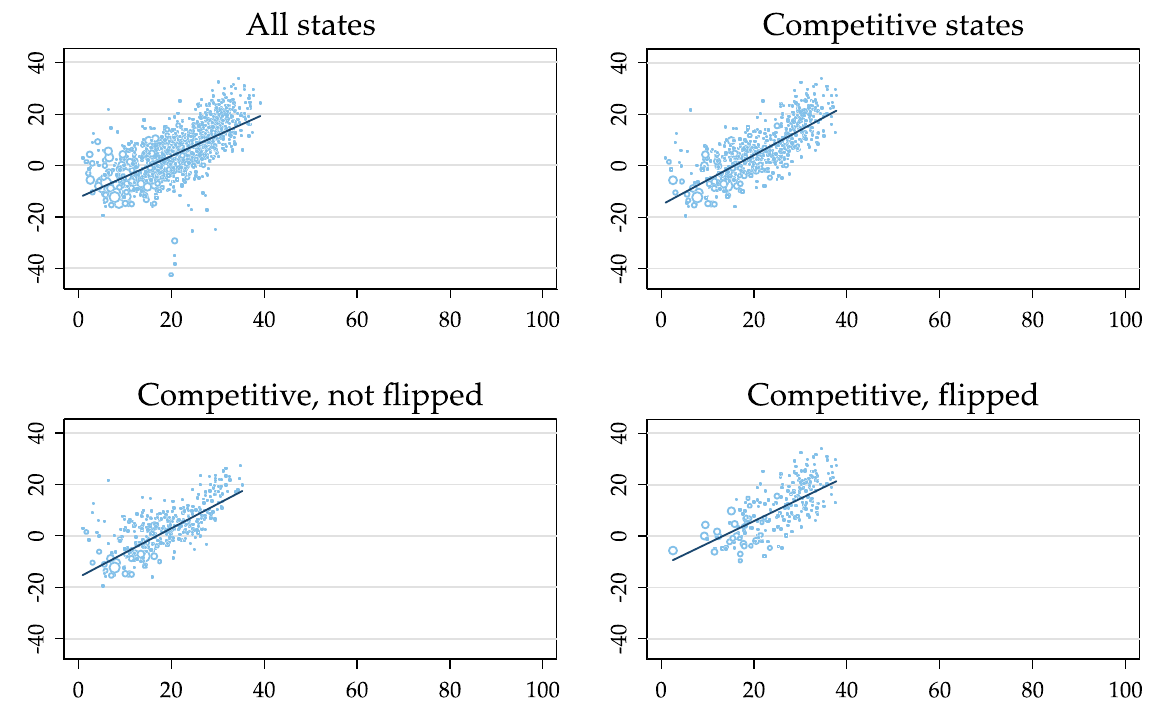
Figure 1: Trump’s 2016 gain by the percentage of the voting population that is WONH and working